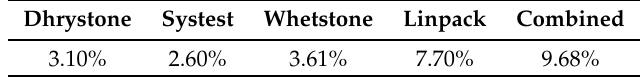
Table 2. Critical vs. essential bits ratio obtained from the unprotected design